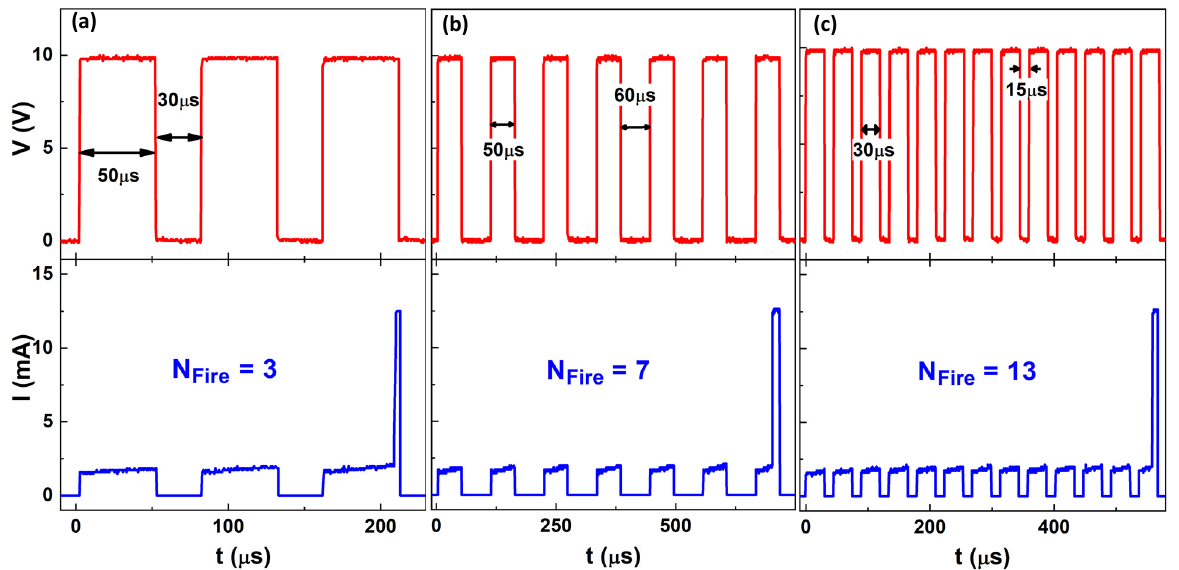
Figure 3. Applied voltage pulse waveforms (top) and measured device current (bottom) for different pulse duty cycles and fixed 10 V amplitude. ( a ) t on = 50 us and t off = 30 us, ( b ) t on = 50 us and t off = 60 us, and ( c ) t on = 15 us and t off = 30 us.